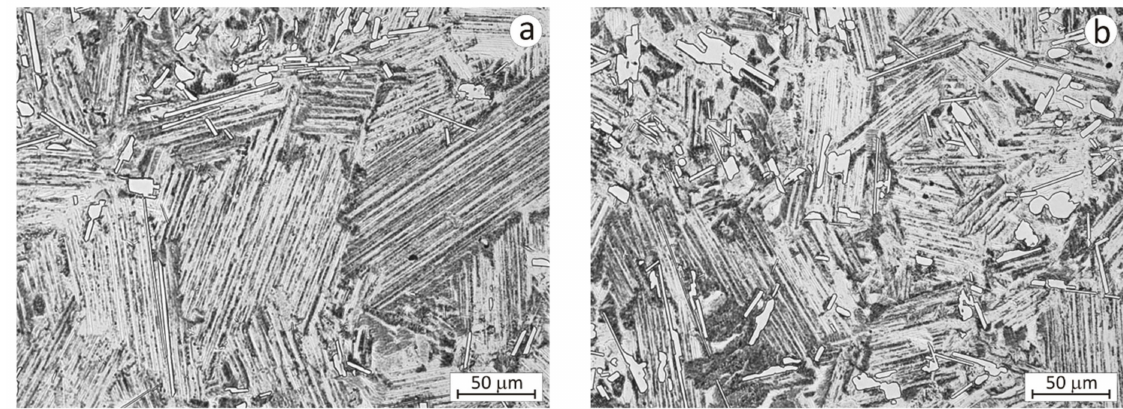
Figure 7. Microstructure of produced Ti-45Al-8Nb-0.5(B,C) ( a ) and reference TNB-V2 ( b ) alloys.